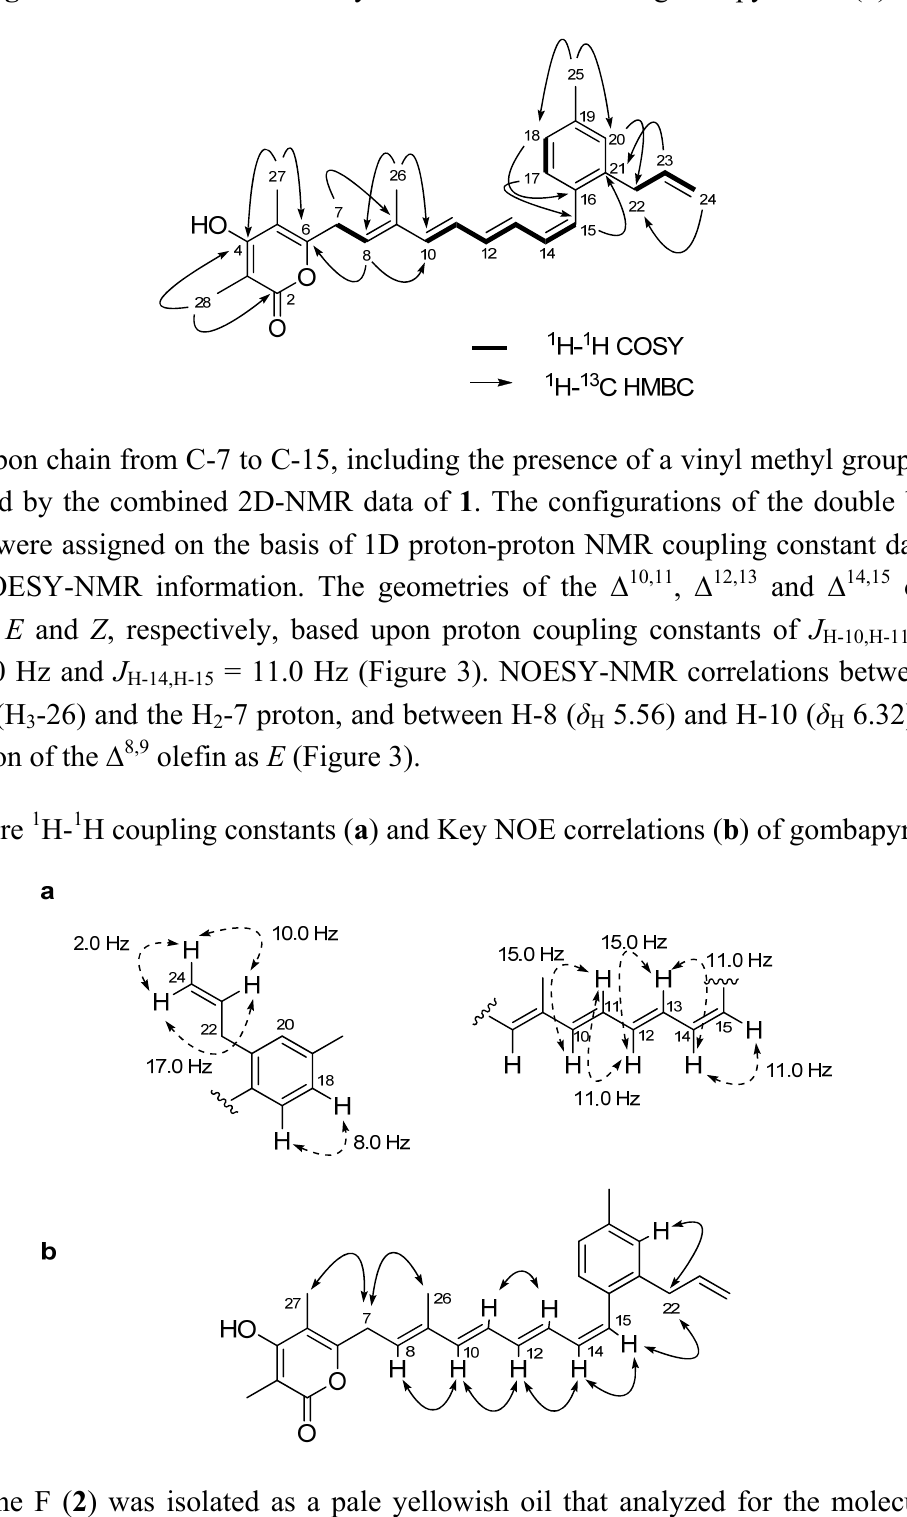
Figure 2. 1 H- 1 H COSY and Key HMBC correlations of gombapyrone E ( 1